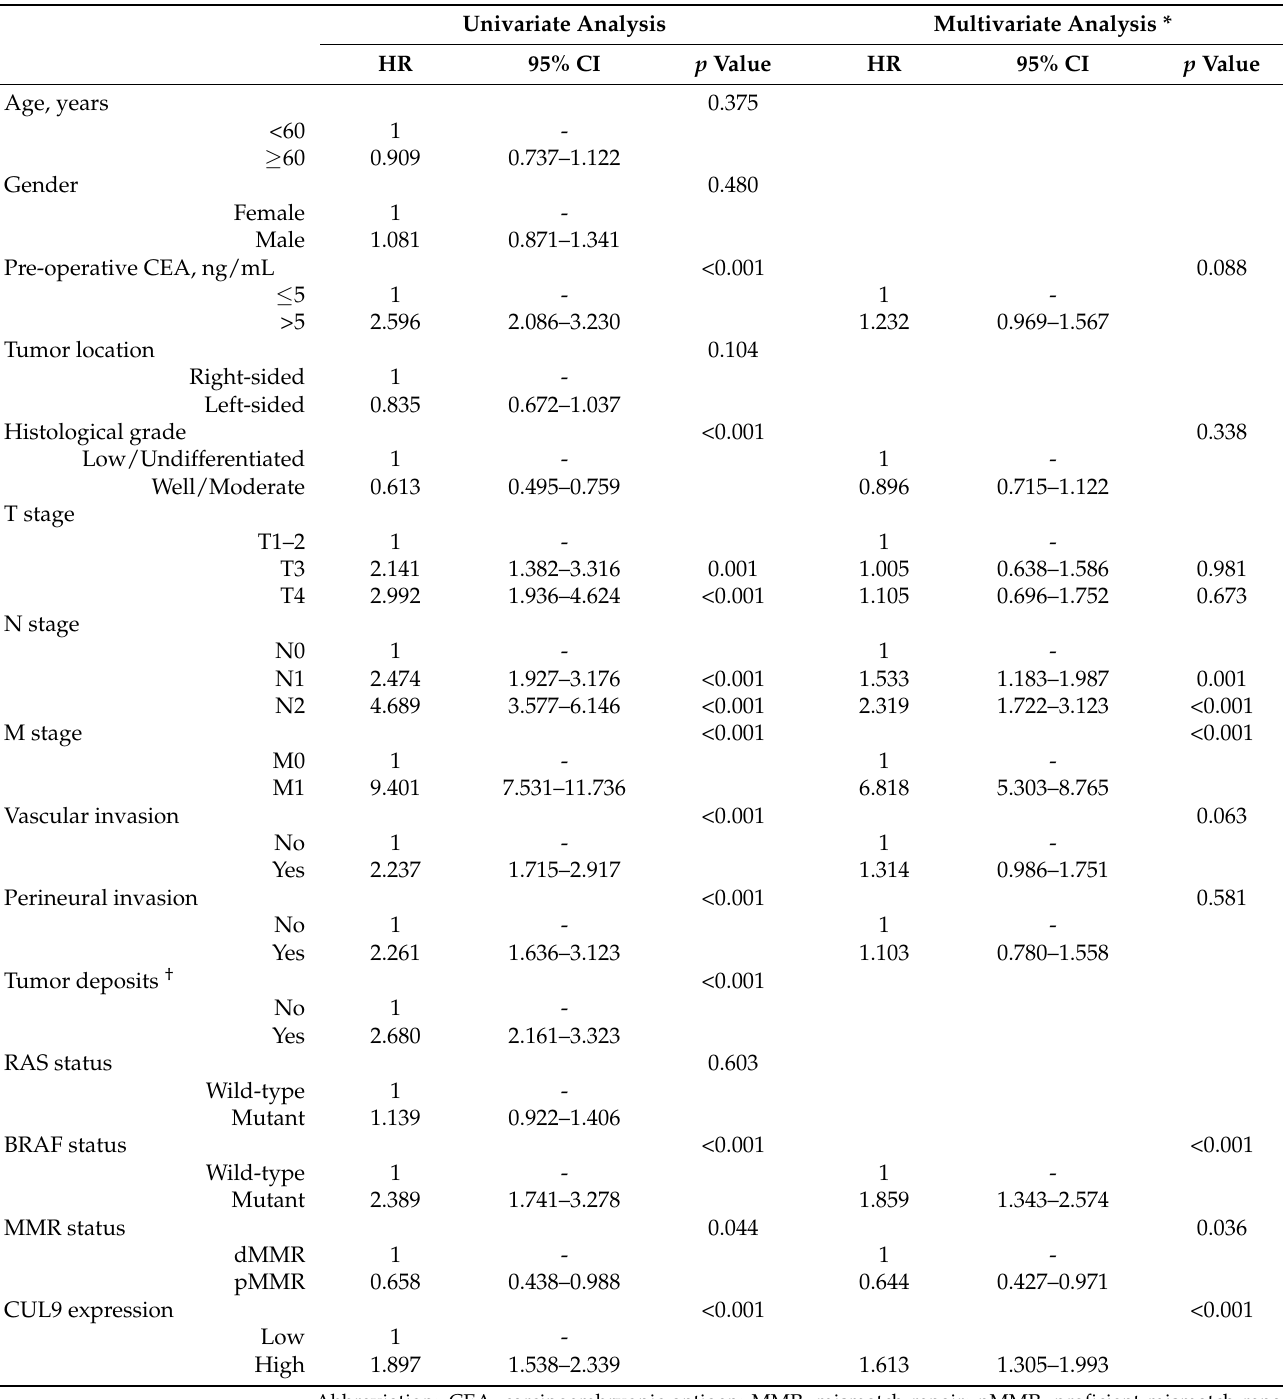
Table 2. Uni- and multivariate analysis of overall survival in the primary cohort. Univariate Analysis Multivariate Analysis